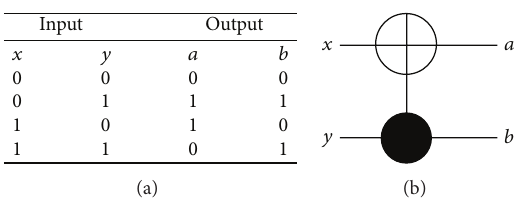
Figure 10: The CNOT gate: (a) truth table, (b) reversible circuit representation.